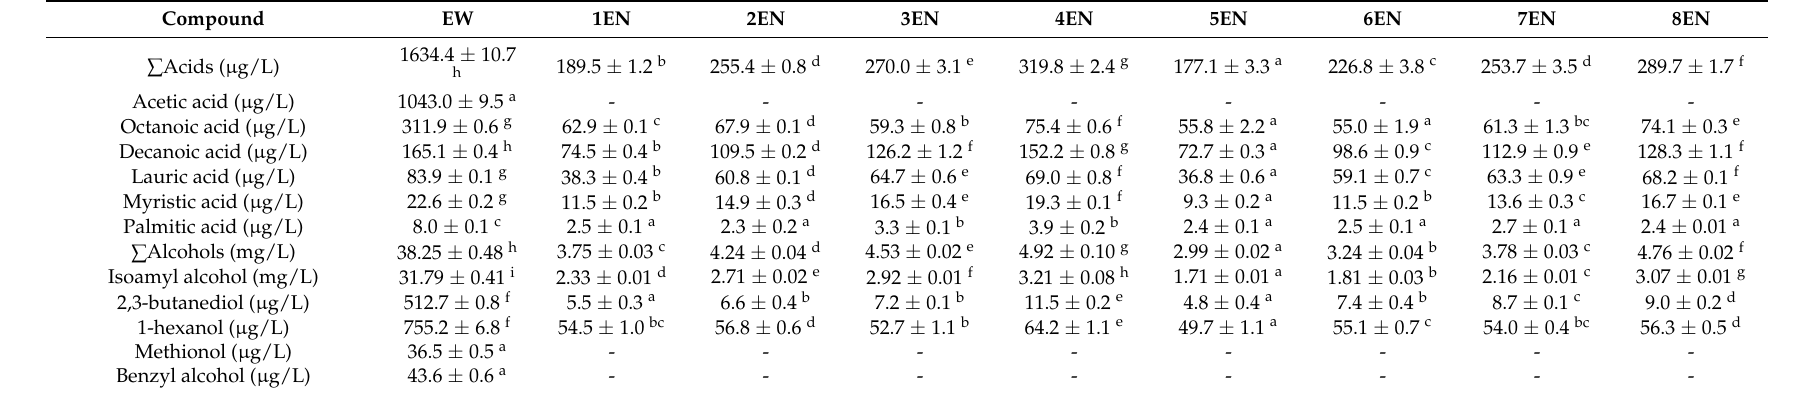
Table 4. Volatile compounds identified in ecological Cabernet Sauvignon red wine and nanofiltration retentates at 2.5, 3.5, 4.5 and 5.5 MPa with cooling and without cooling. Different superscript letters (a, b, c, d, e, f, g, h, i) in the same row represent statistical difference by ANOVA, Fisher’s (LSD) test ( p <